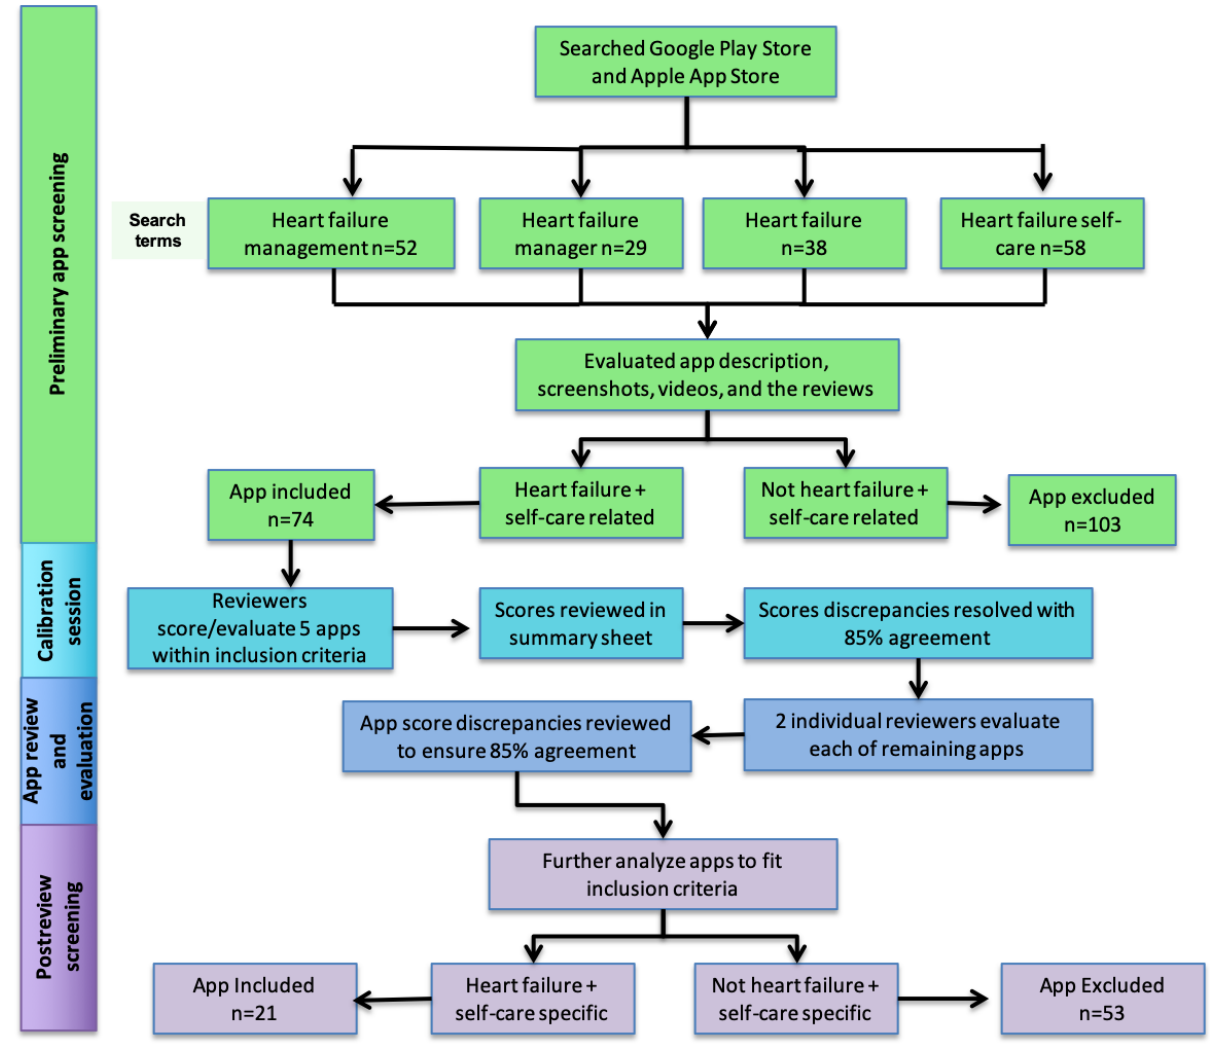
Figure 2. Conceptual study design of the mobile health app